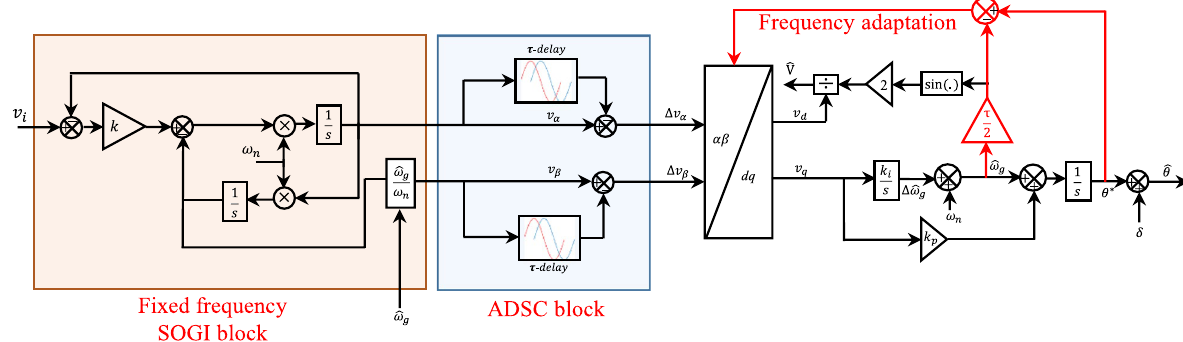
Fig. 1 The proposed FFSOGI-PLL with DC offset rejection capability. The SOGI is used to construct the orthogonality. Arbitrarily delayed signal cancelation is used to remove the DC offset from the orthogonal